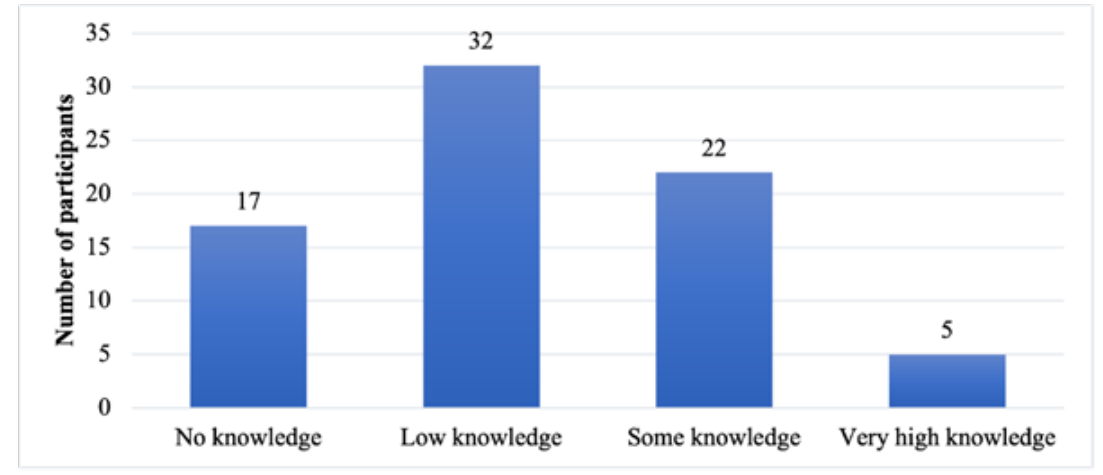
Figure 3. Knowledge levels on the effects of the MC on injury occurrence